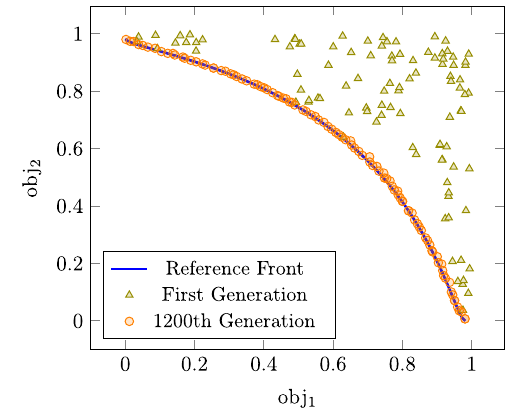
FIG. 4. Variator benchmark after 1100 function evaluations using binary crossover and independent gene mutations (each gene mutates with probability p ¼ 1